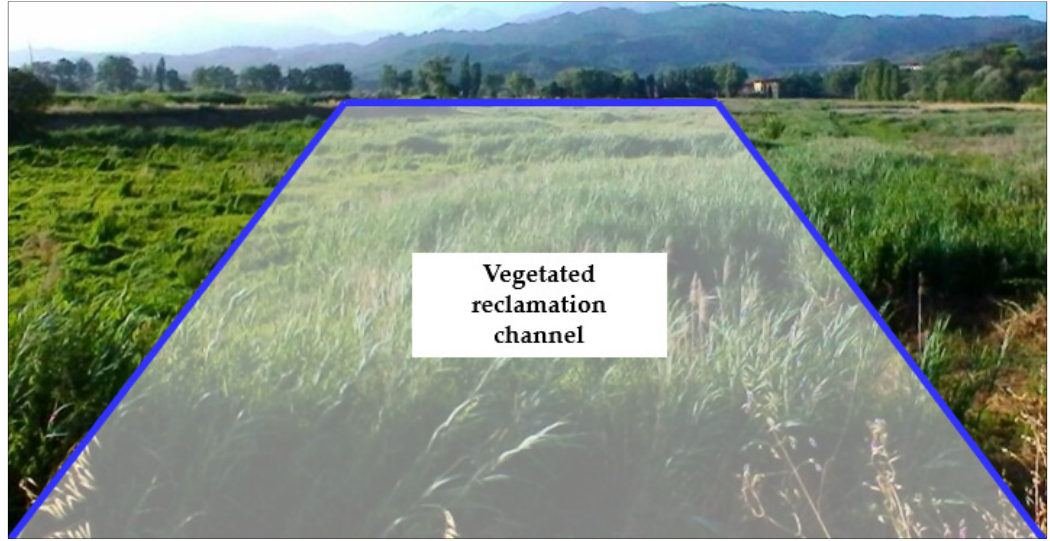
Figure 3. View of the 500-m long vegetated reclamation channel. The continuous blue lines indicate the borders of the vegetated reclamation channel.